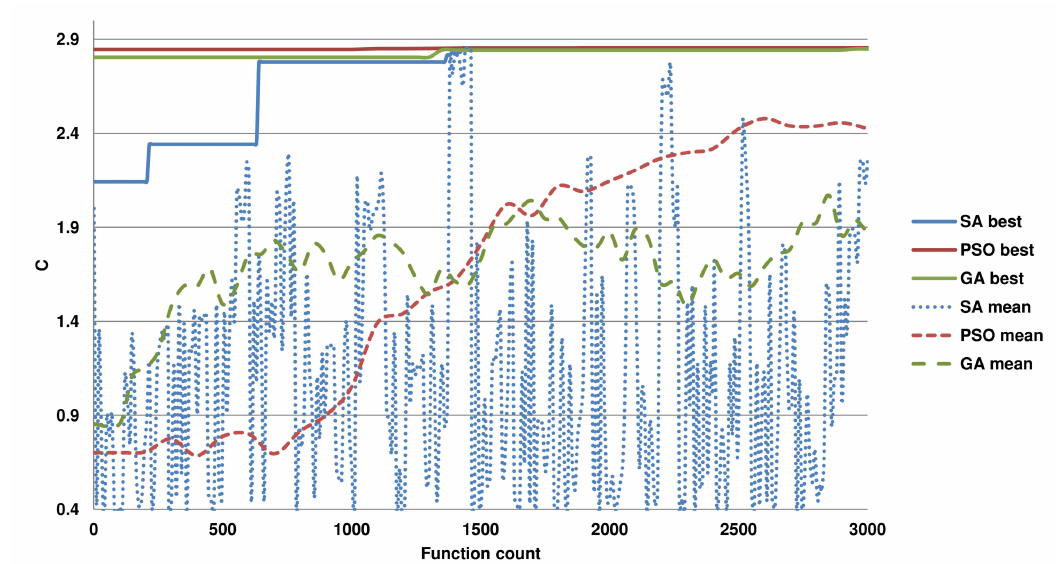
Figure 2. Convergence plots for the values of C 4 for sample runs of the hybrid approach with the Particle Swarm Optimization (PSO), Simulated Annealing (SA), and Genetic Algorithm (GA). The plots contain the best result at each function call and the mean value of C 4 for the processed solutions.